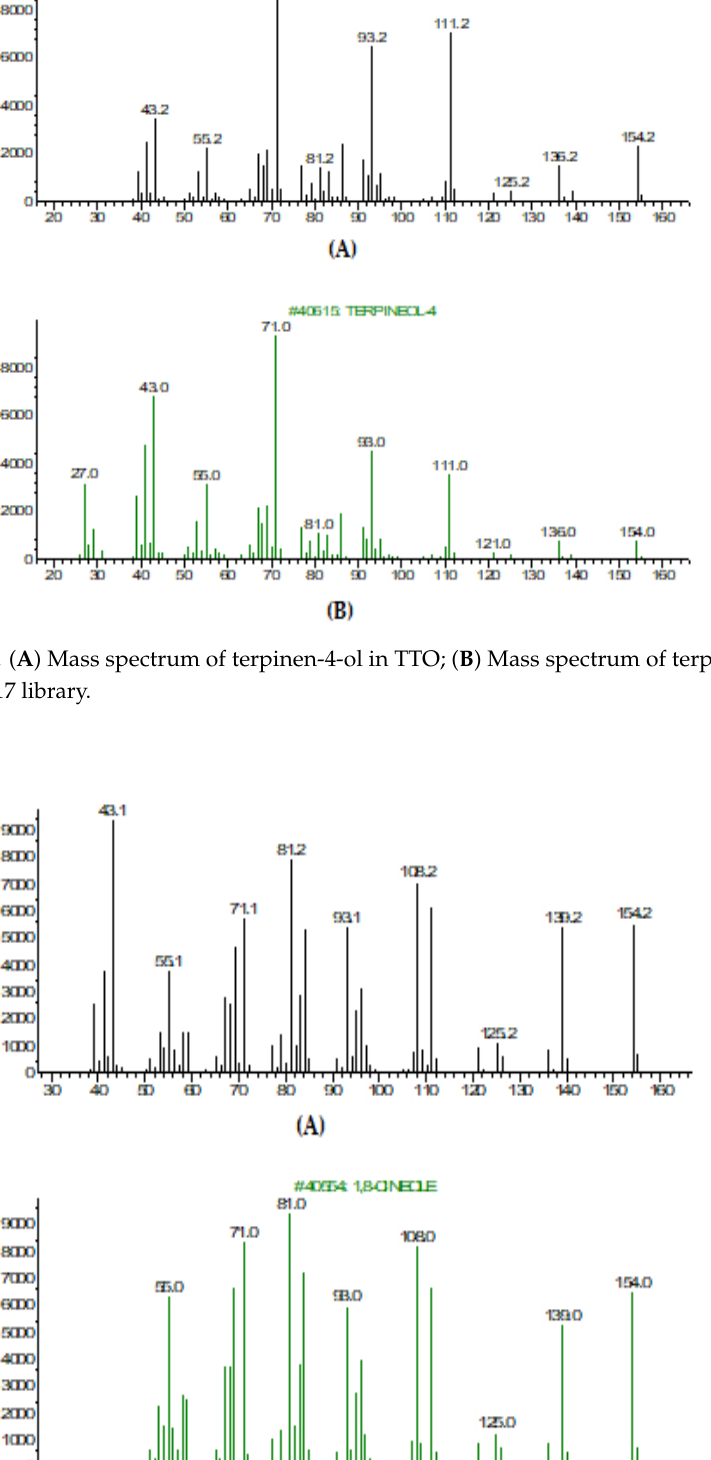
Figure 4. ( A ) Mass spectrum of 1,8-cineole of pure sample; ( B ) Mass spectrum of 1,8-cineole from the NIST-2017 library. According to the phytochemical analysis of the substance based on TTO, 1,8-cineole and (-)- α -bisabolol (ratio 1:1:1), eighteen chemical phytoconstituents were identified, rep- resenting 98.64% of the total composition. We found three nonidentified compounds (Fig- ure 5) that could be related to the main compounds of the plant-based substance.